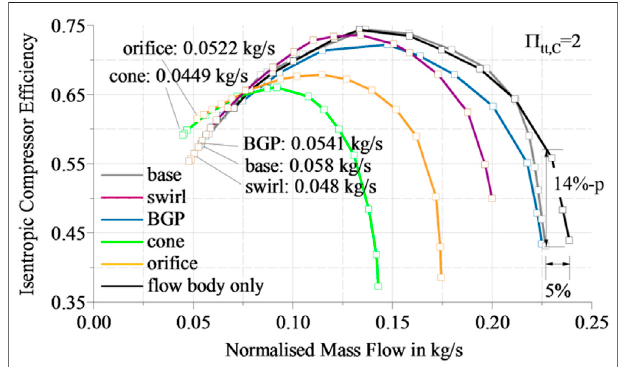
FIGURE12| Isentropic compressor ef fi ciency fordifferentinserts and at a constant compressor pressure ratio of 2. Values in kg/s indicate surge limit for each